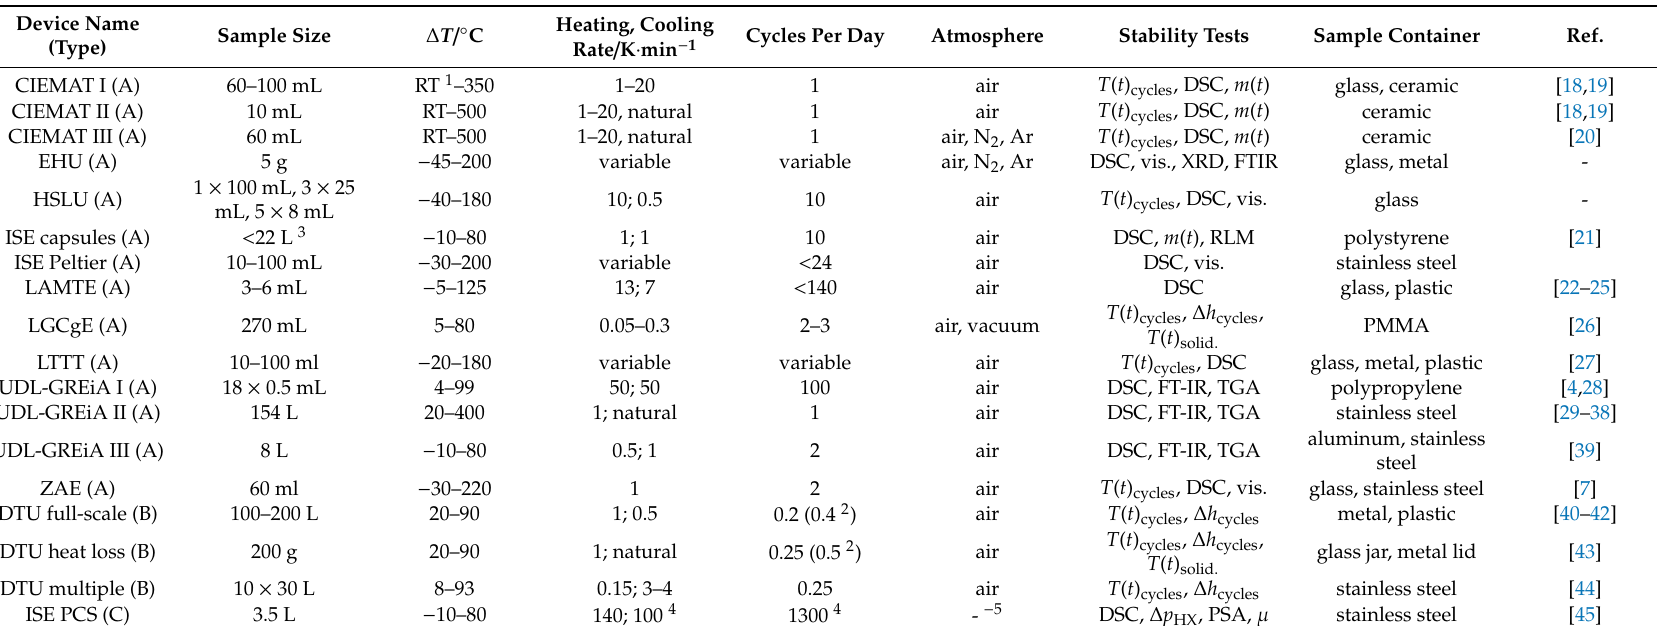
Table 1. Specifications of testing devices (device types A–C explained in Section 2.1). Explanations of columns: typical size (range) of the investigated sample; temperature range of measurements ∆ T ; heating and cooling rates between isothermal segments; typical number of melting–solidification cycles per day; atmosphere the PCM sample is in contact with; abbreviations used for stability tests: T ( t ) cycles = comparison of temperature–time curves of di ff erent cycles, m ( t ) = sample mass monitoring after certain number of cycles or time, vis. = visually, ∆ h cycles = comparison of the thermal energy content in repeated storage cycles, T ( t ) solid. = temperature profile during material solidification, ∆ p HX = pressure loss of cooling heat exchanger, µ = viscosity measurement, further abbreviations in nomenclature; material of sample